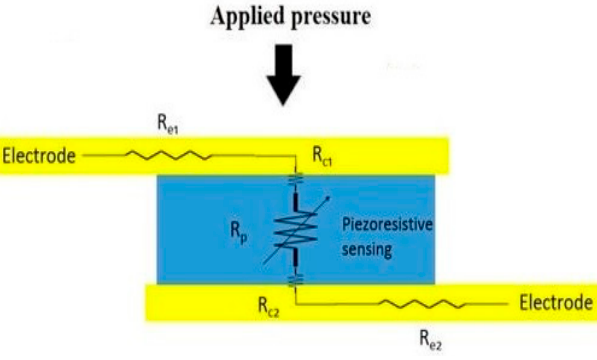
Figure 5. The working principle of the resistive sensors. The sensor consists of a variable resistor, which is the piezoresistive sensing element [42]. The resistive values of this element vary according to the magnitude and direction of the pressure applied to the sensors.